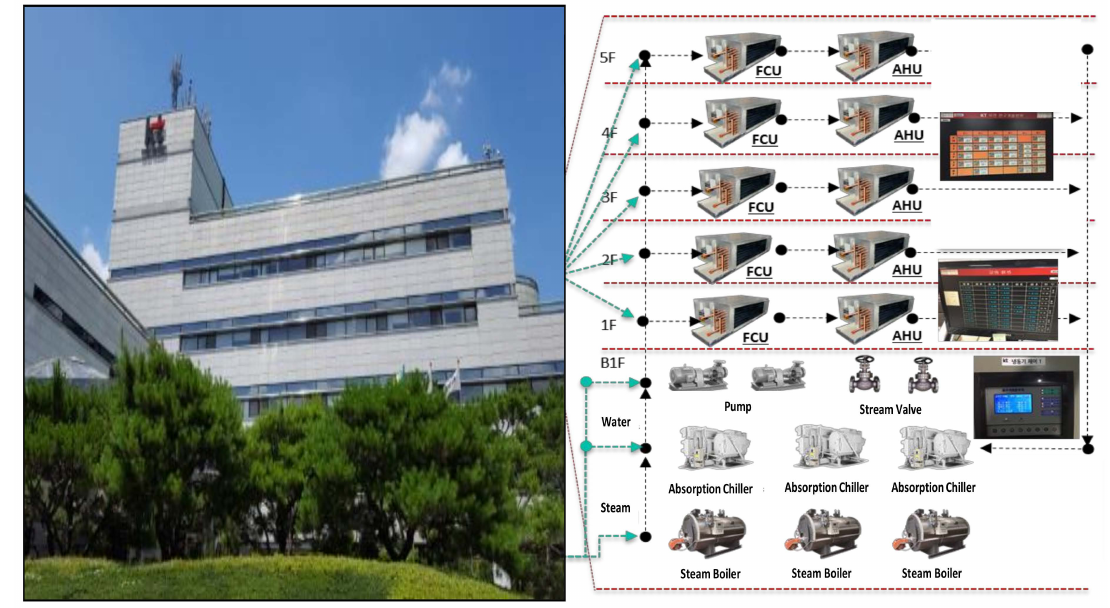
Figure 3. Diagram of R&D center energy e ffi ciency